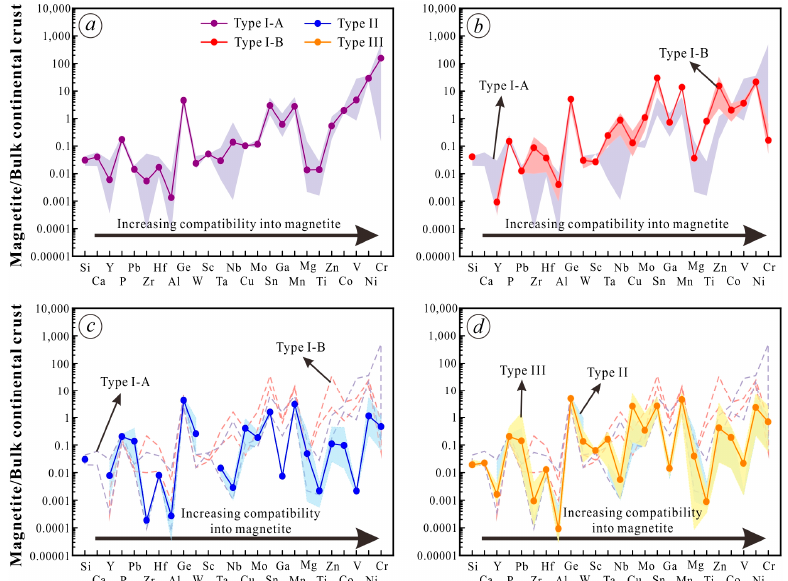
Figure 5. Multielement variation diagrams for different types of magnetite in the Jinchuan Ni-Cu-PGE deposit. Normalized to bulk continental crust values are from [48]. Note: The selected elements in this figure were sequenced by their increasing compatibility into magnetite using the compilation of experimental and empirical partition coefficients between magnetite and silicate magmas. More details can be found in [2] and references therein.